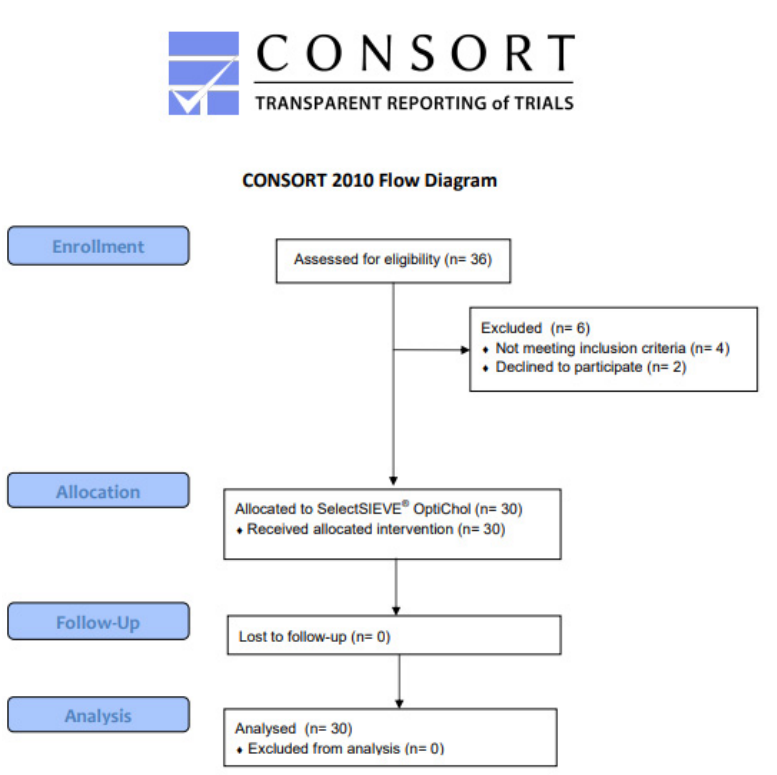
Figure 2. CONSORT (Consolidated Standards of Reporting Trials) flow diagram. Table 2. Diet composition (g/day) at enrollment and at the end of the intervention. Values are reported as mean ±